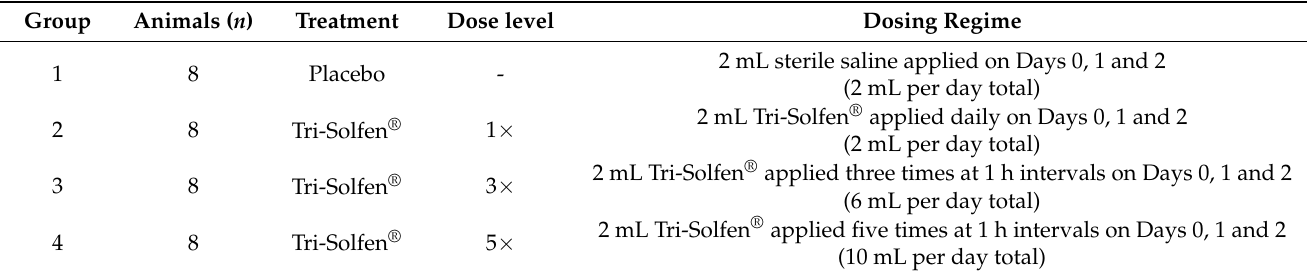
Table 1. Treatment regime for animals in Study